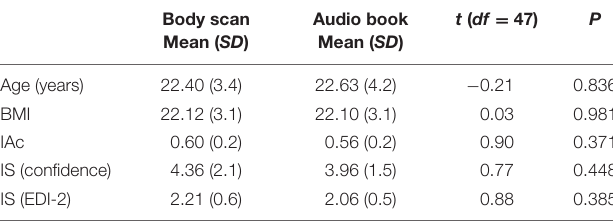
TABLE 1 | Descriptive variables of body scan and audio book at